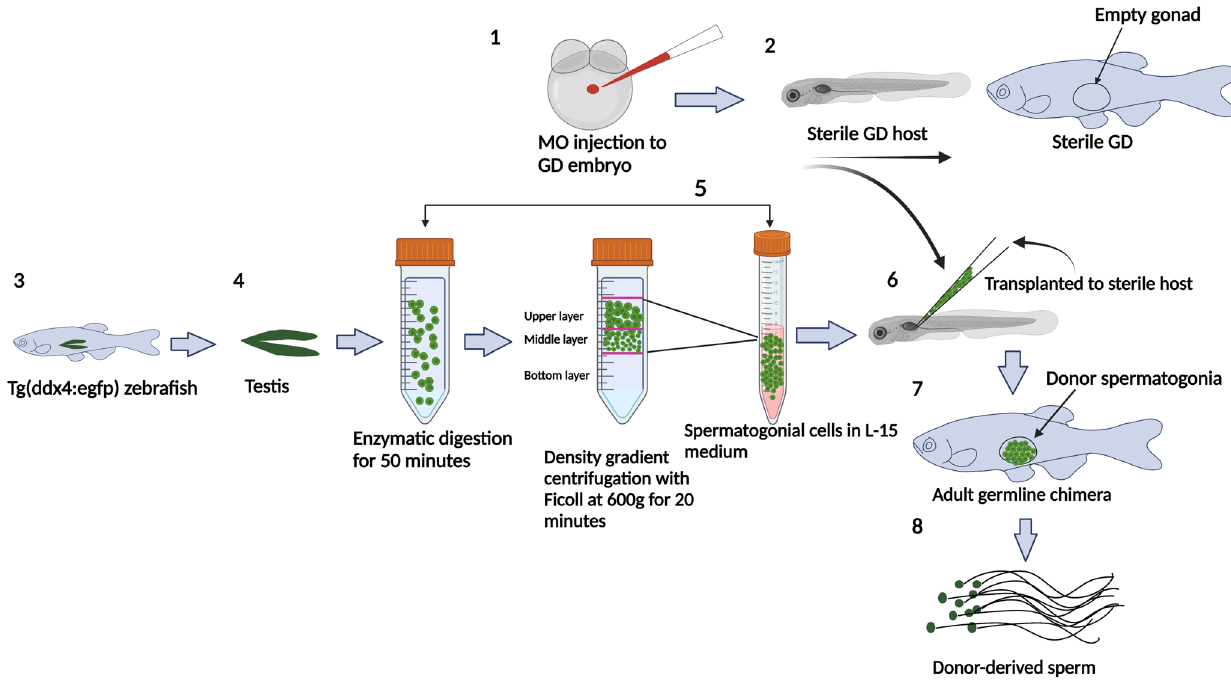
Fig. 1 Schematic of study design. GD-giant danio, MO-dead-end antisense morpholino oligonucleotide, L-15-Leibovitz ’ s L-15 Medium. This fi gure was created with BioRender.com.